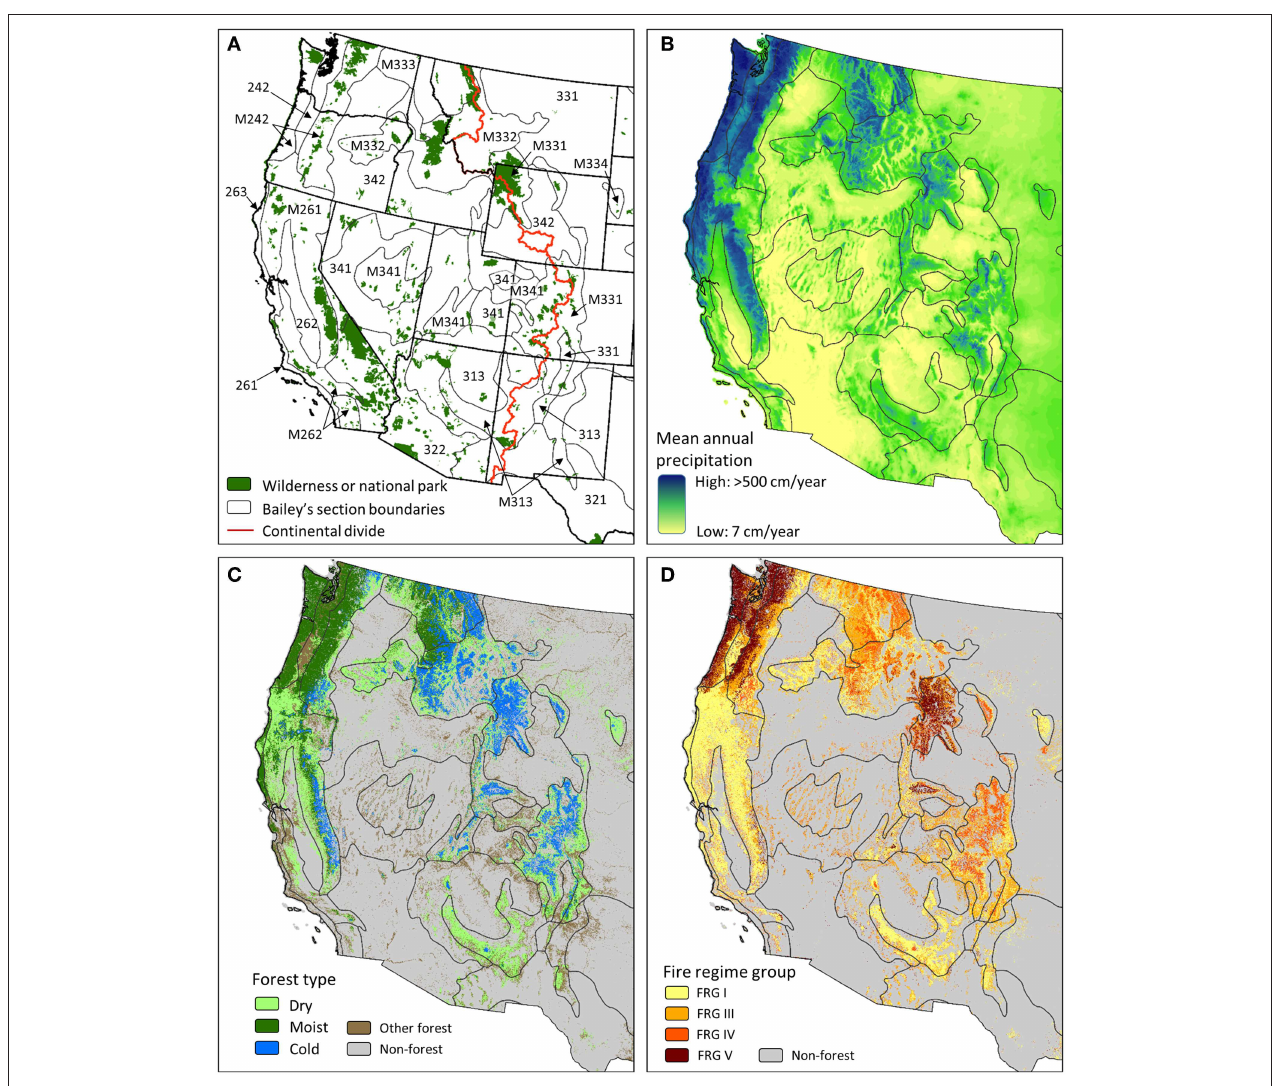
FIGURE 6 | Maps depict (A) protected areas (designated wilderness and national park) and section-level ecoregion boundaries, (B) mean annual precipitation, (C) forest types, and (D) fire regime groups (FRGs) for the contiguous western US. The “other forest” type in panel (C) includes forest types that are not addressed in this paper, such as pinyon-juniper woodlands and riparian forests. FRG classes are FRG I: fire return interval ≤ 35 years, low and mixed severity; FRG III: fire return interval 35–200 years, low and mixed severity; FRG IV: fire return interval 35–200 years, replacement or high-severity; FRG V: fire return interval > 200 years, any severity. Portions of the study area that extend into Mexico and Canada are not shown because not all datasets are coextensive to these regions. Data sources: Bailey sections—(Bailey, 1998); (B) —(Daly et al., 2008); (C,D) —(Rollins, 2009)